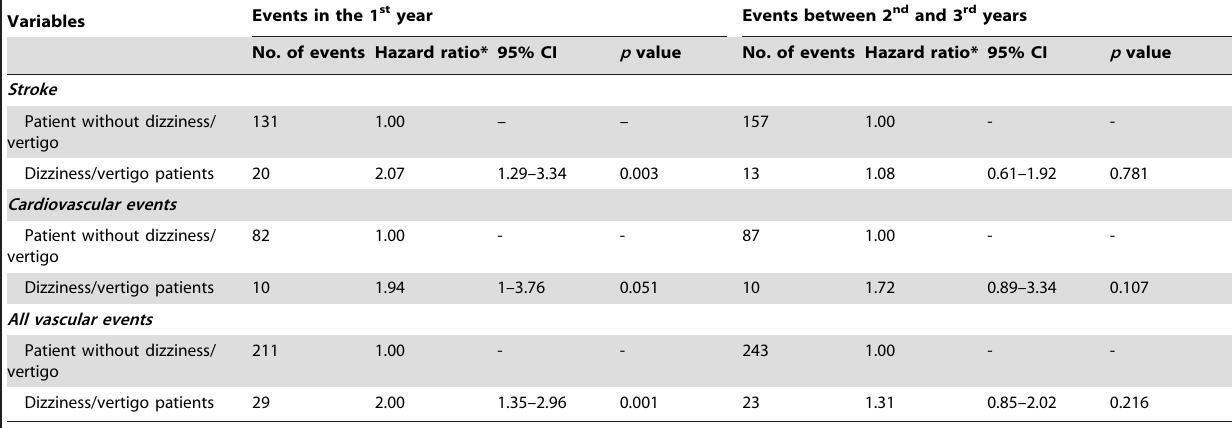
Table 4. Hazard ratios of stroke, cardiovascular events, and all vascular events among the ER dizziness/vertigo patients and patients without dizziness/vertigo stratified by time; 240 vascular events in the first year of follow-up and 266 vascular events between 2 nd and 3 rd years.